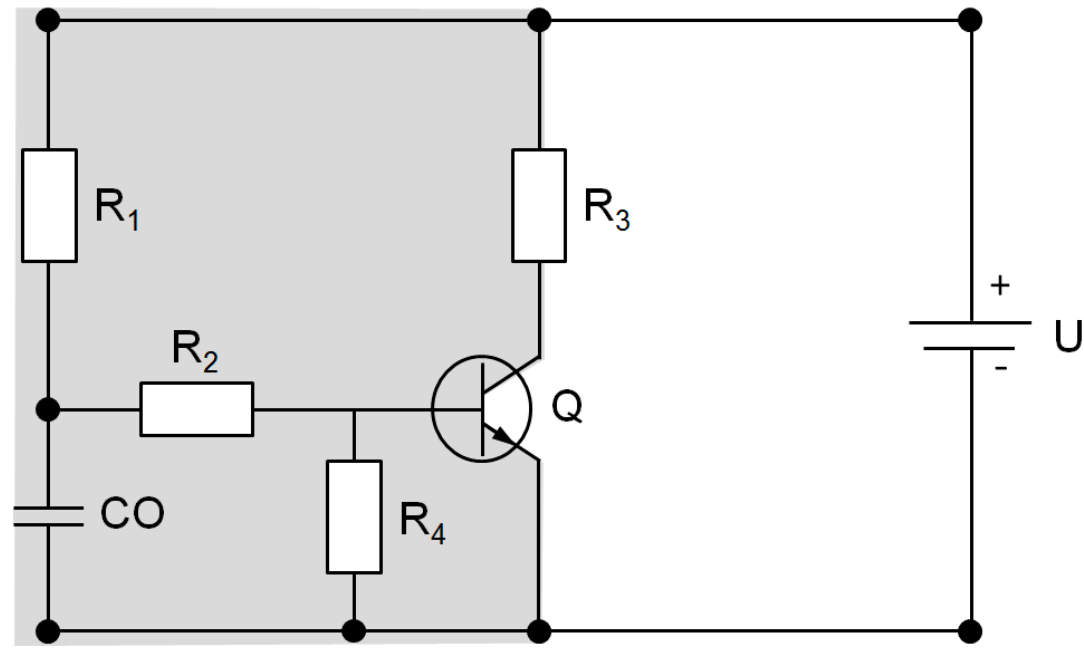
Figure 6. Circuit diagram as a model of van B VRE transmission on the early rehabilitation ward ( grey area , left side ) of Ingolstadt Hospital (ERWIN) and other wards of the hospital ( white area , right side ). R 1 = Resistor representing infection control measures on ERWIN. R 2 = Resistor resulting from probiotic treatment. R 3 = Resistor composed of infection control measures on the other wards of the hospital. R 4 = Resistor necessary due to technical reasons. Q = Transistor enhancing spread of van B VRE on the other wards depending on the VRE situation on ERWIN. CO = Condenser representing VRE load of staff members. U = Driving force of VRE transmission in the hospital.